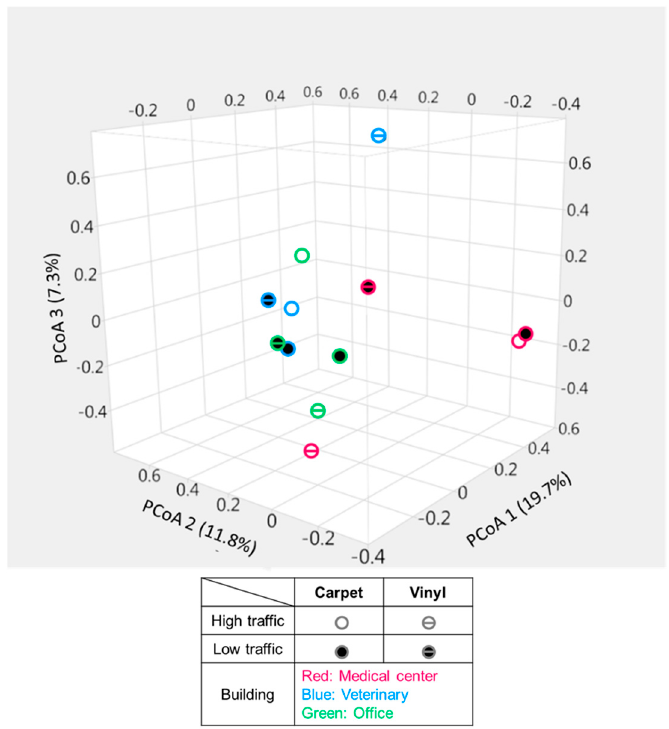
Figure 4. Principal coordinate analysis plot showing the similarity relationships among the bacterial community from the floor